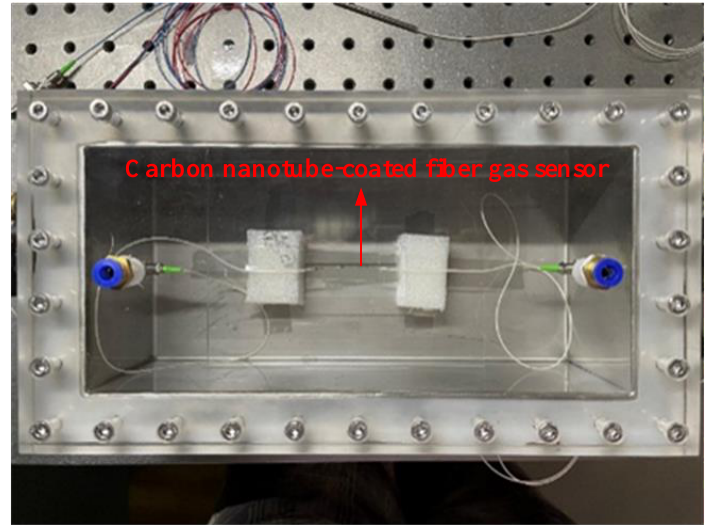
Figure 1. Gas detection cell.